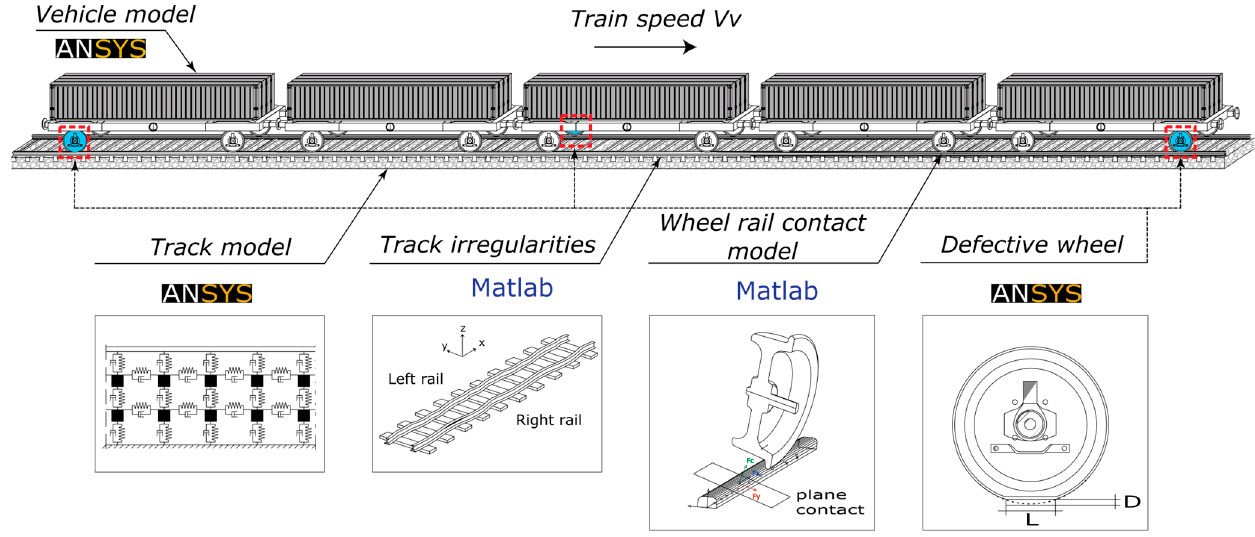
Figure 1. Numerical modeling of the train–track system.